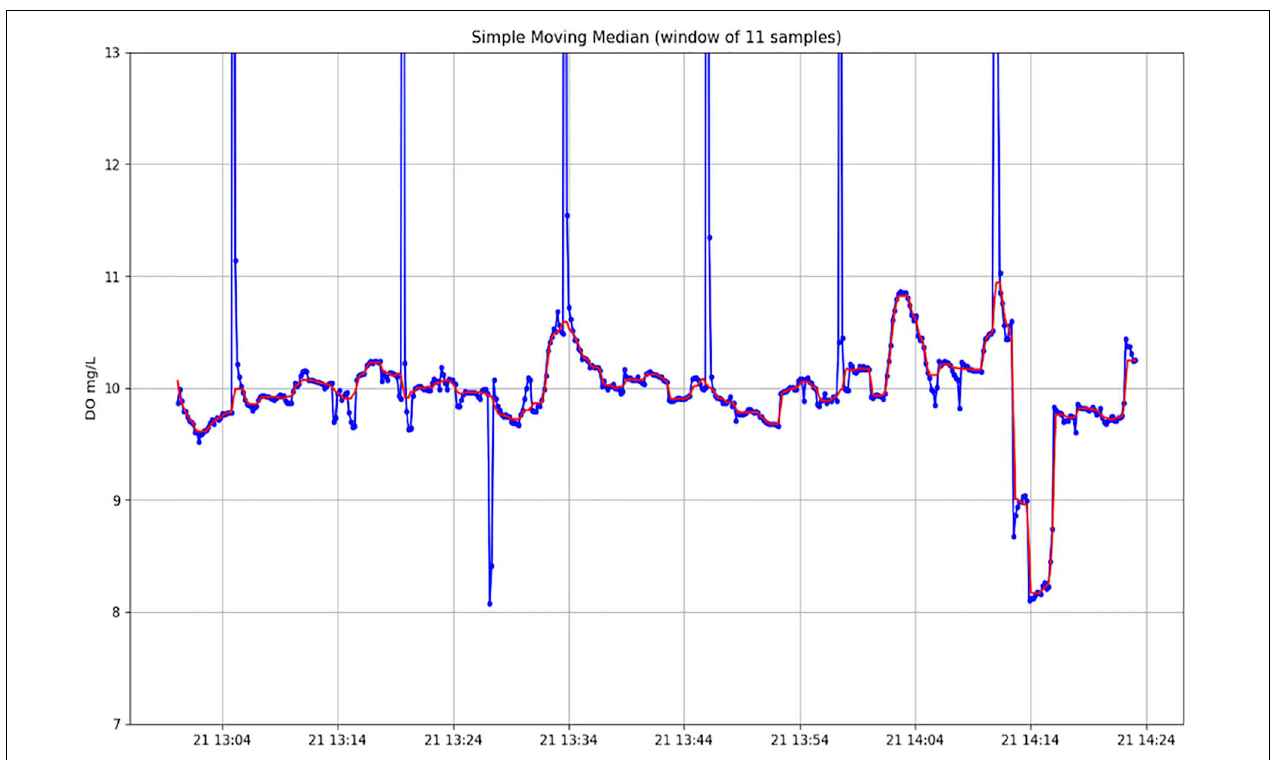
FIGURE 12 | Data quality control, validation, and